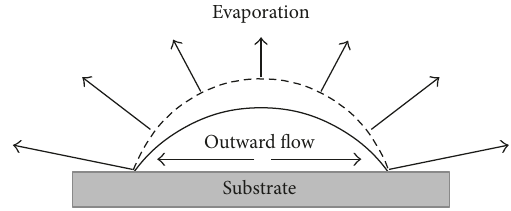
Figure 5: Evaporation and TPCL pinning as the origin of outward flow inside evaporating sessile droplet [22]. Initial position of the free surface is shown as the dashed line, whereas its new position due to evaporation is shown as the solid line.